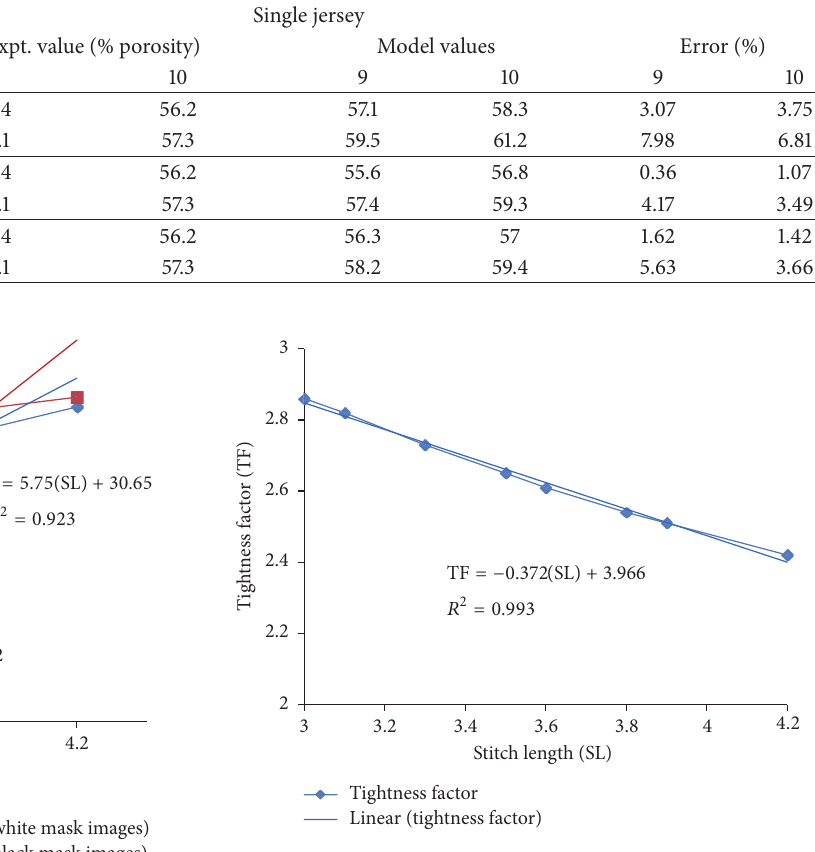
Figure 13: Tightness factor against stitch length for